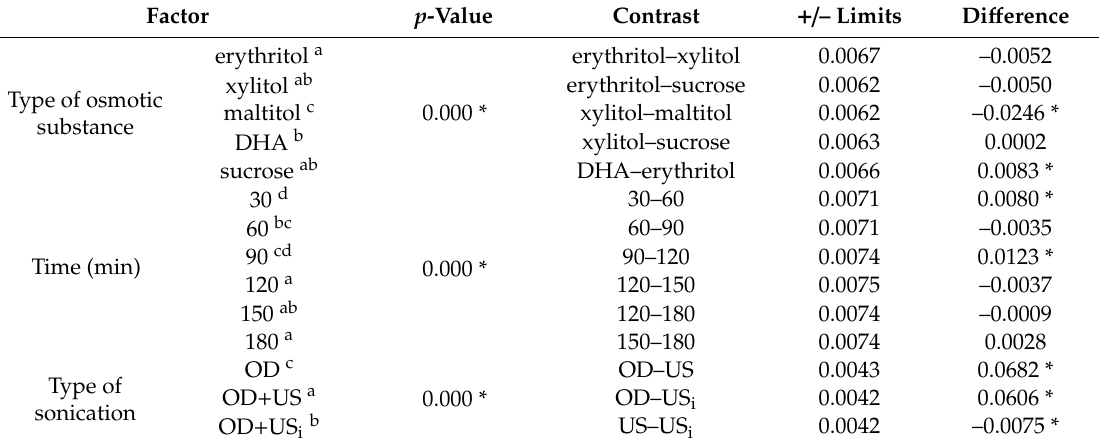
Table 11. The influence of osmotic agents and pre-treatment time on water activity during OD. Factor p -Value